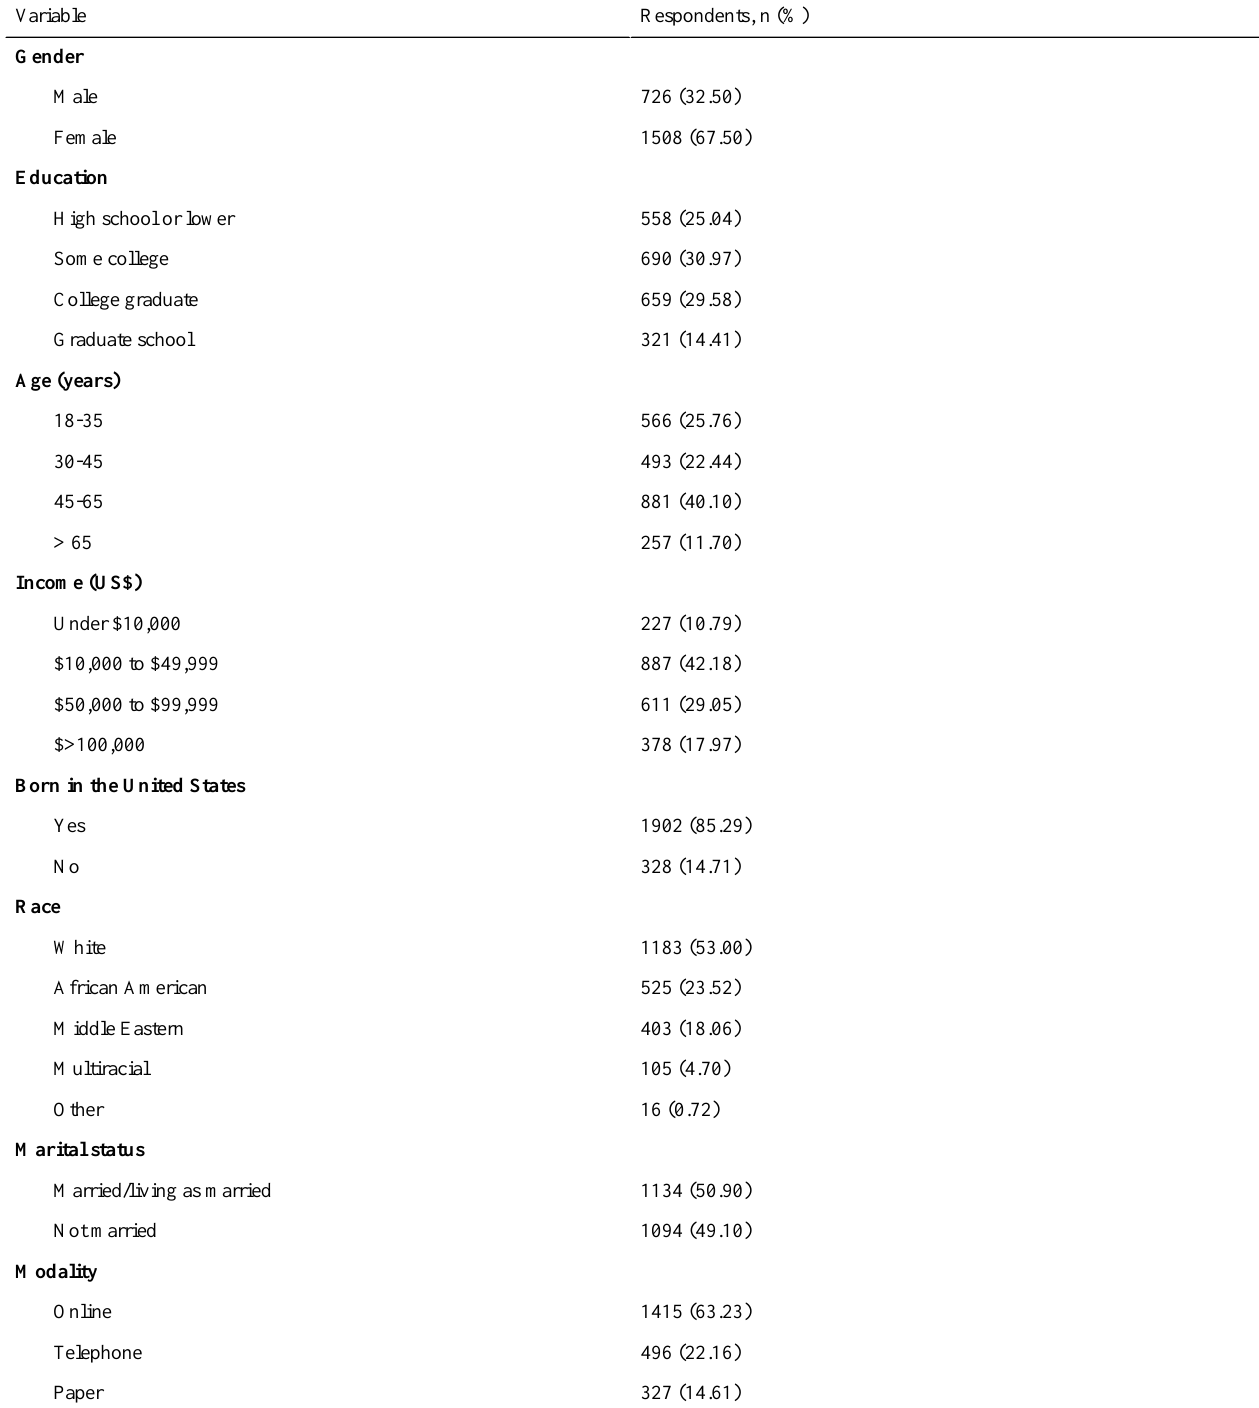
Table 1. Sample demographics